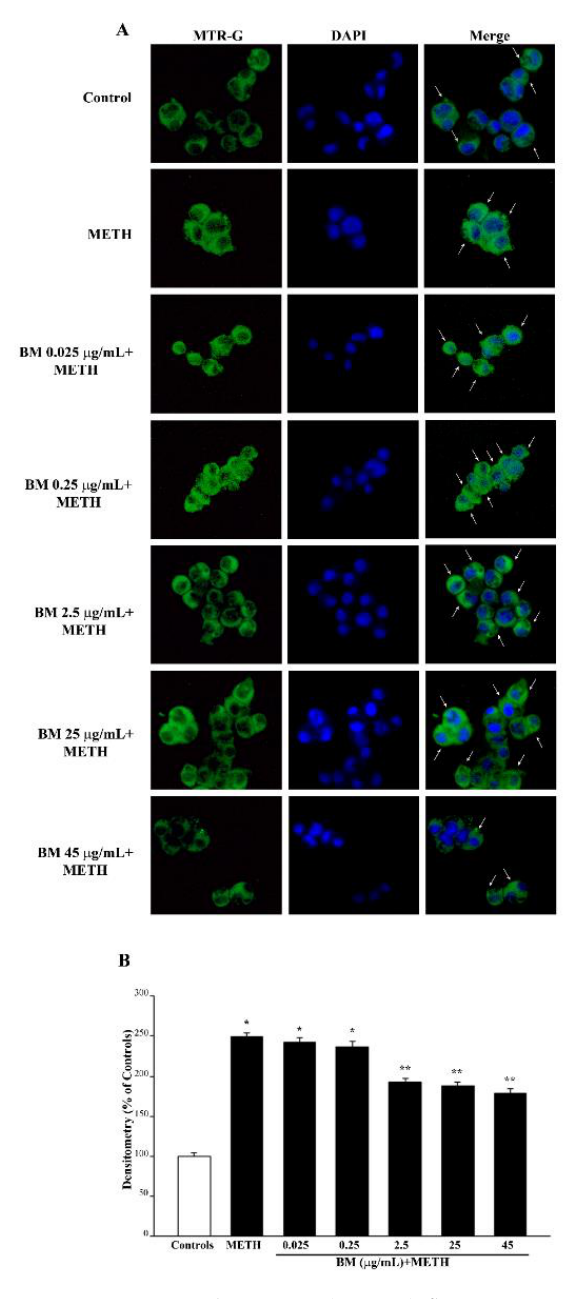
Figure 12. MitoTracker Green (MTR-G) fluorescent cells after combined administration of BM and METH. ( A ) Representative pictures of MTR-G fluorescence show that METH increases MTR- G fluorescence compared with control. This effect is less pronounced when METH is given in combination with BM from the dose of 2.5 µ g/mL up to the dose of 45 µ g/mL. This replicates what is observed under BM alone. Cell nuclei are stained in blue with DAPI. The graph in ( B ) reports MTR-G fluorescence intensity. Values are given as mean percentage ± S.E.M. of optical density (assuming controls as 100%) from three independent experiments. * p < 0.05 compared with controls; ** p < 0.05 compared with METH. Scale bar = 17 µ